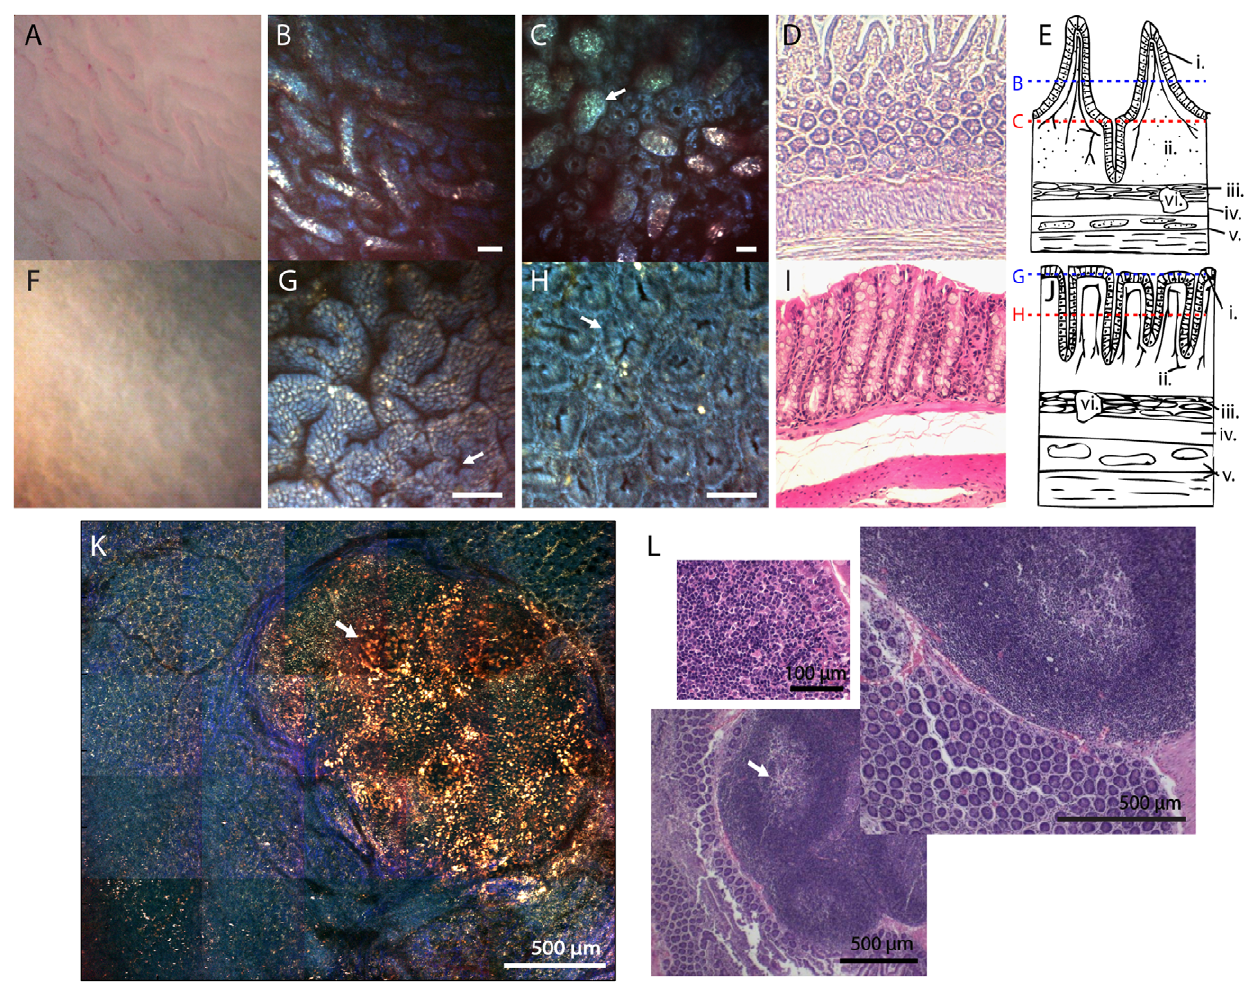
Figure 1. Comparison of small intestine and colon using white light imaging, two-photon microscopy and conventional H&E histology. Two-photon images are shown as RGB merges normalized to the thresholded maximum of each channel. Scale bar is 50 m m except where otherwise noted. (A) An en-face white light image of fresh tissue from normal small intestine at 20 6 magnification provides a 2D view of the villi laying flat. (B) The same field of view as in A acquired using two-photon microscopy of intrinsic contrast with 740 nm excitation. It is possible to distinguish between the epithelial layer that covers the villi (blue) and the core of each villus (yellow). (C) A two-photon image of a deeper layer of the small intestine reveals intestinal glands, or crypts of Lieberku¨hn at the base of the villi. Arrow points to villi. (D) Cross-sectional H&E histology of the small intestine showing the layers of the mucosa. B was acquired at the villi level and C was acquired at the crypt level. (E) Schematic morphology of the small intestine. Epithelium (i.) covers the villi and forms the crypts. Lamina propria (ii.) extends into the core of the villi and contains a vascular network. The remaining layers are the muscularis mucosa (iii.) submucosa (iv) and the muscularis externa (v). Lymphoid aggregates or Peyer’s patches of varying size (vi.) are found in the submucosal layers. (F) White light image of fresh, normal colon tissue at 20 6 magnification. (G) A two-photon image of intrinsic contrast showing the folds in the superficial epithelial layer of the colon. Arrow points to the openings to the crypts of Lieberku¨hn. (H) A deeper two-photon image of the same piece of colon tissue revealing densely packed crypts 80 m m below the epithelial layer shown in E. Nuclei are visible as black dots circling the outside of the glands (arrow). (I) Cross-sectional H&E histology of the colon showing that the crypts extend through the full thickness of the lamina propria. (J) Schematic morphology of the colon. Epithelium (i.) lines the mucosa and extends into the lamina propria (ii.) to form the crypts. The remaining layers are the muscularis mucosa (iii.) submucosa (iv) and the muscularis externa (v). As in the small intestine lymphoid aggregates or Peyer’s patches of varying size (vi.) are found in the submucosal layers. (K) Two photon image of a Peyer’s patch found in the small intestine. Scale bar is 500 m m. Arrow points to a germinal center of the lymphoid aggregate. L Shows a range of H&E stained Peyer’s patches at similar magnification to K (inset shows 40 6 fine detail of